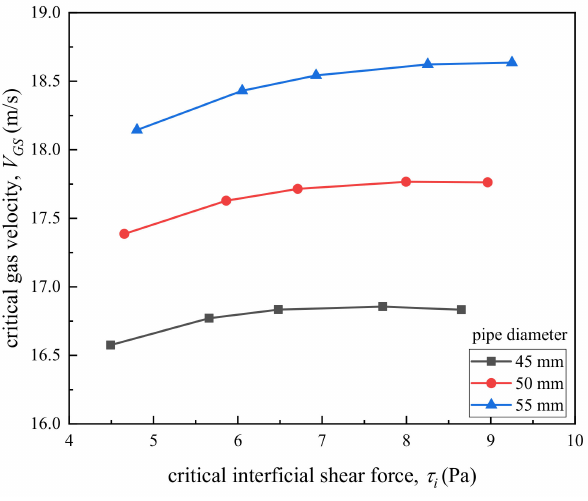
Figure 3. The relationship between critical gas velocity and critical interface